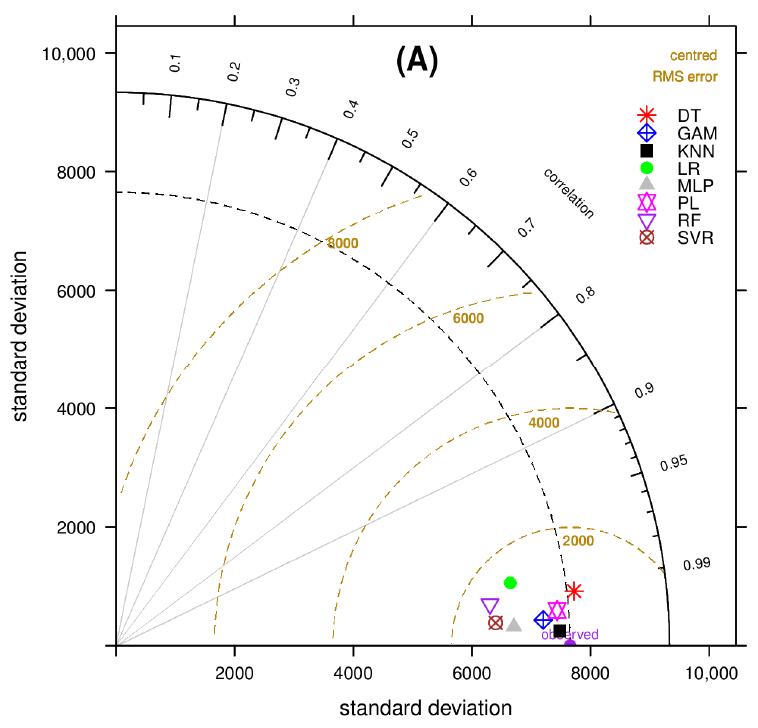
Figure 7. Taylor diagram, displaying statistical comparison of the eight model predictions against the actual number of recorded active cases—WWTP A. Table 4. Top-three regression models for prediction in each